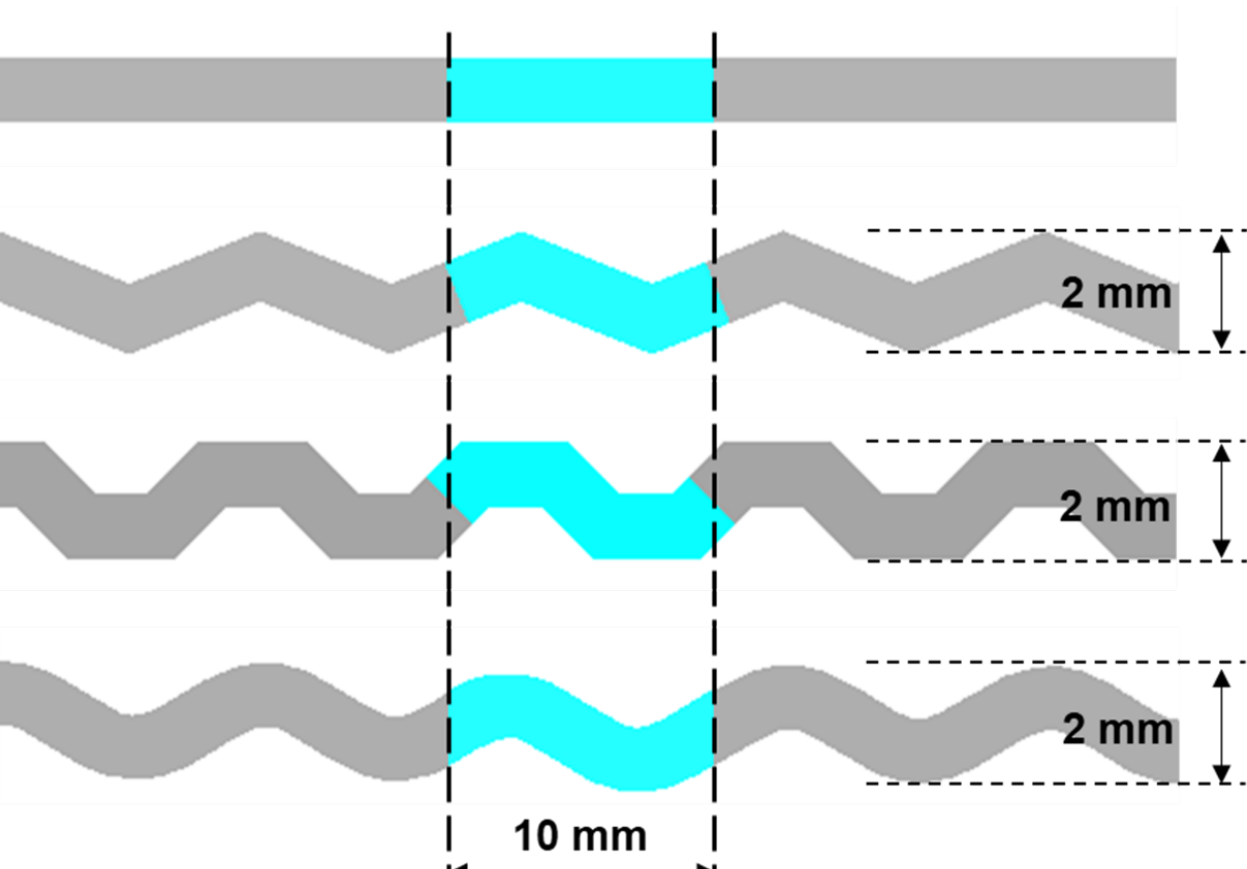
Figure 5. Channel models of the straight, the zigzag, the S-shape, and the trapezoidal structures.